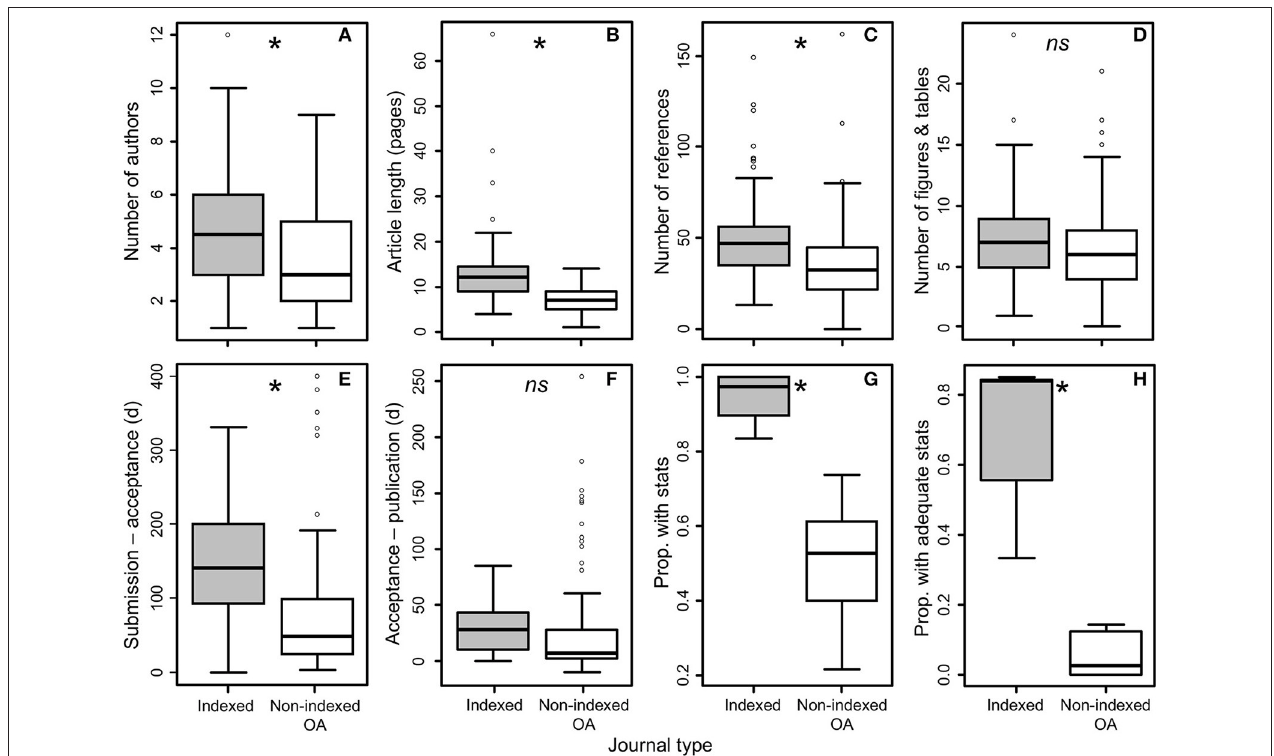
FIGURE 3 | Boxplot representation of non-demographic article level metrics for indexed (gray boxes) and non-indexed OA (white boxes) journals, including the number of authors (A) , the article length (in pages) (B) , the number of references (C) , the number of figures and tables (D) , the time (in days) from submission to acceptance (E) and the time from acceptance to publication (F) , and the proportion of articles reporting basic (G) and detailed statistical analyses (H) . Asterisks denote significant differences between journal types; ns denotes non-significant differences (see Table 3 ). See Methods section Data collection for details on sample